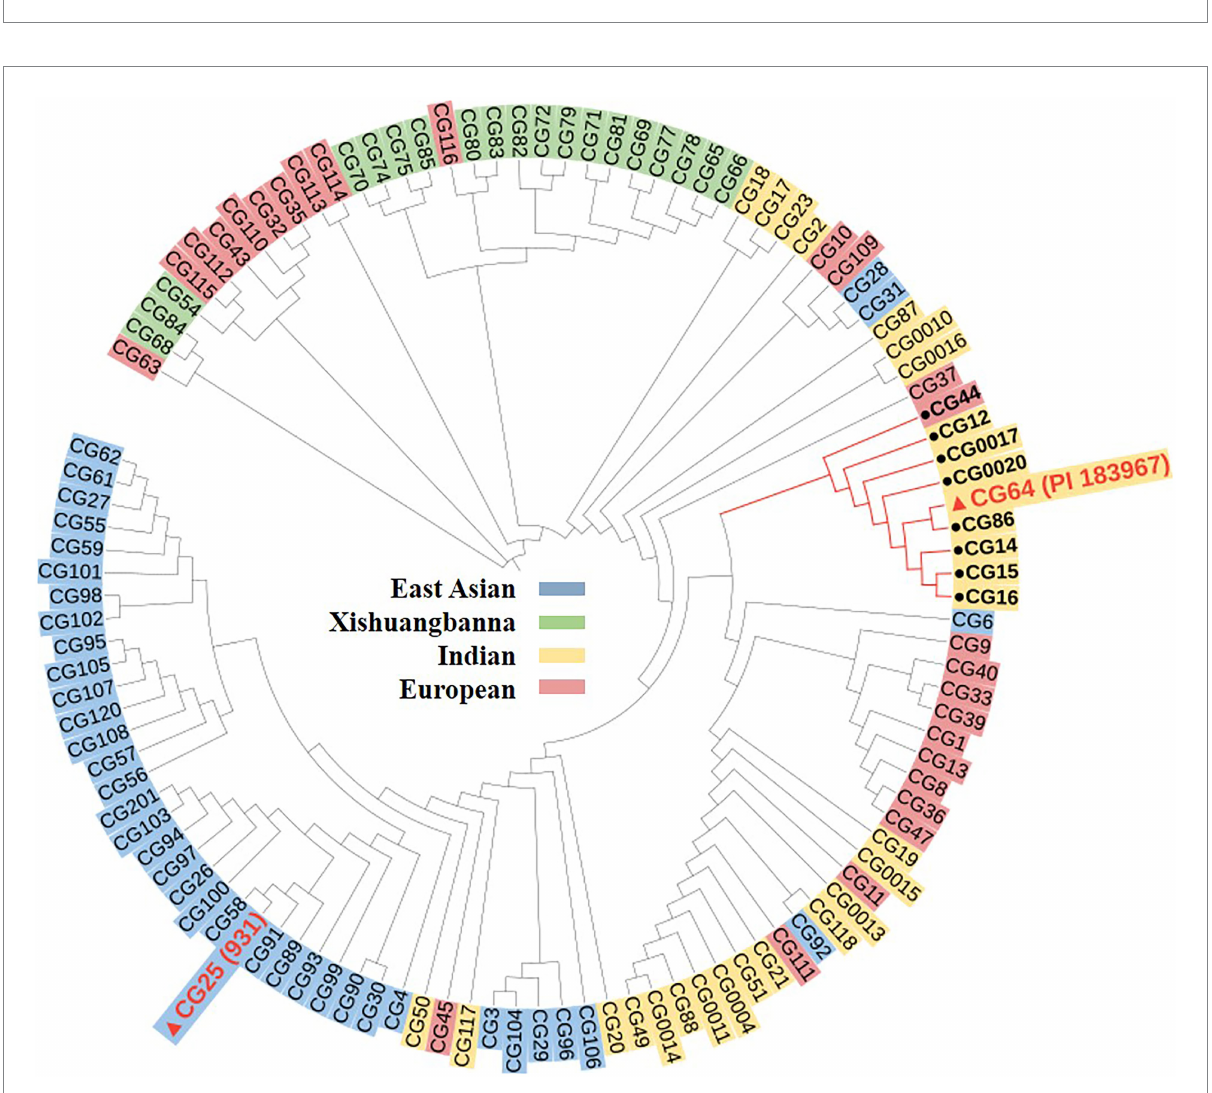
FIGURE 8 Phylogenetic analysis for gsb3.1 locus. A dendrogram of 113 cucumber accessions analyzed using 333 SNPs derived from Qi et al. (2013) within the delimited 38-kb gsb3.1